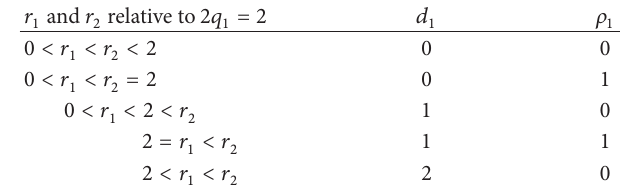
Table 1: 𝑑 𝑖 and 𝜌 𝑖 for 𝑖 = 1 .